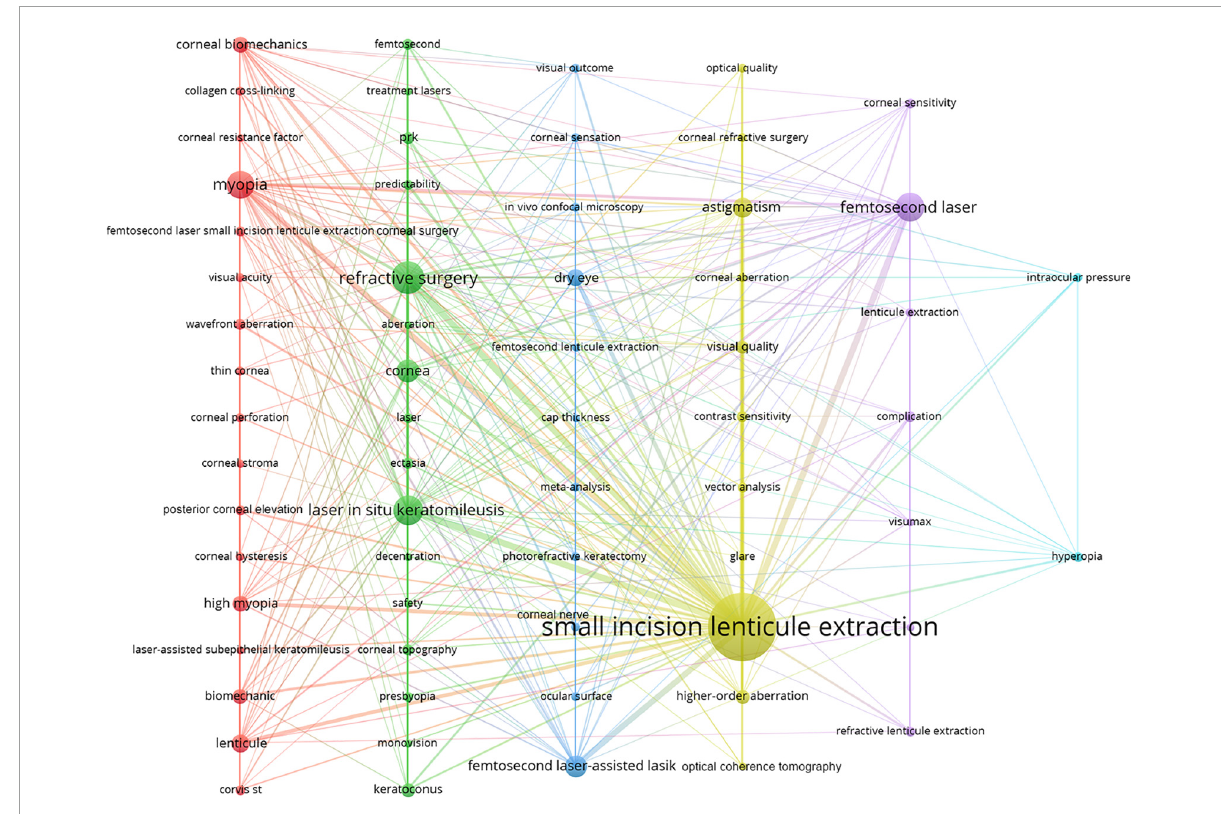
FIGURE5 The network map of keywords for SMILE